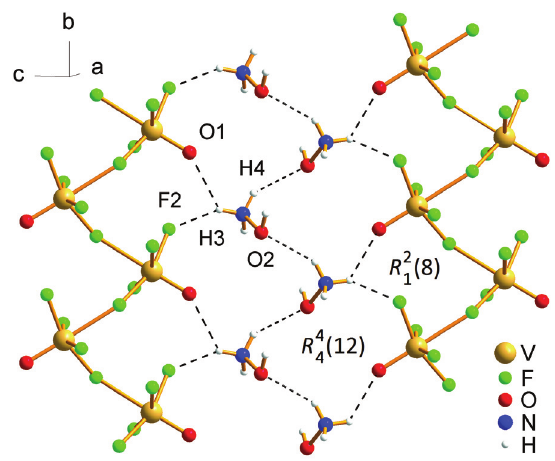
Figure 3. Hydrogen-bonded zigzag cationic chain flanked by two zigzag 1